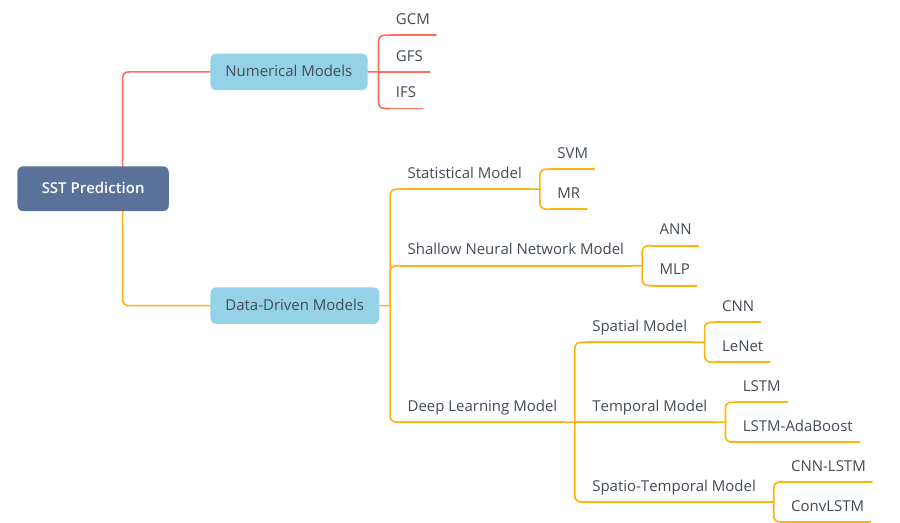
Figure 1. The taxonomy of existing SST prediction